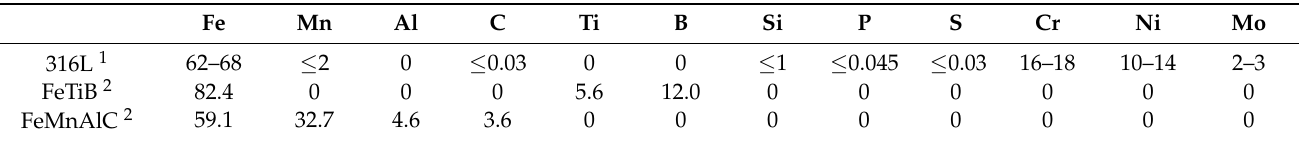
Table 1. Chemical composition in WT% of particles utilized for cold spraying ( 1 according to [28]; 2 according to in house measurements, cf. [29]).